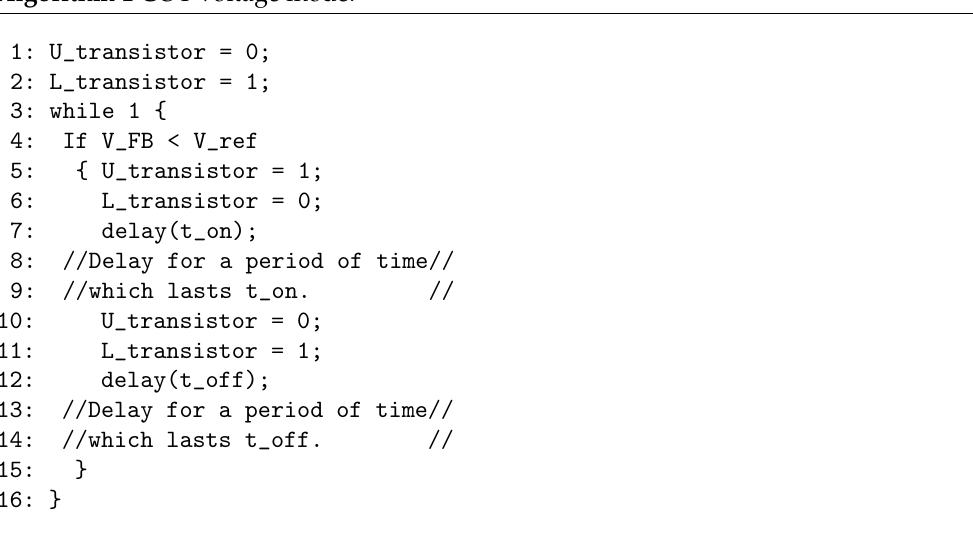
Algorithm 1 COT voltage